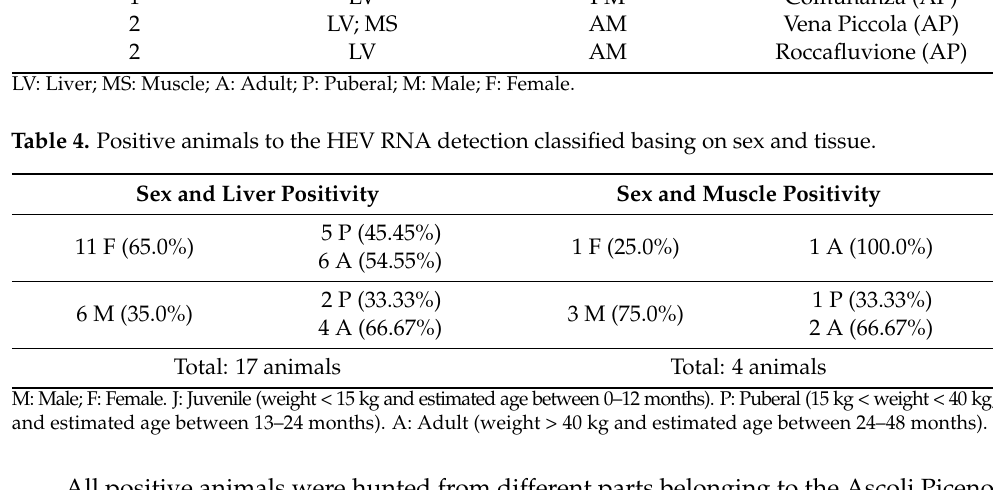
AF Venarotta (AP)